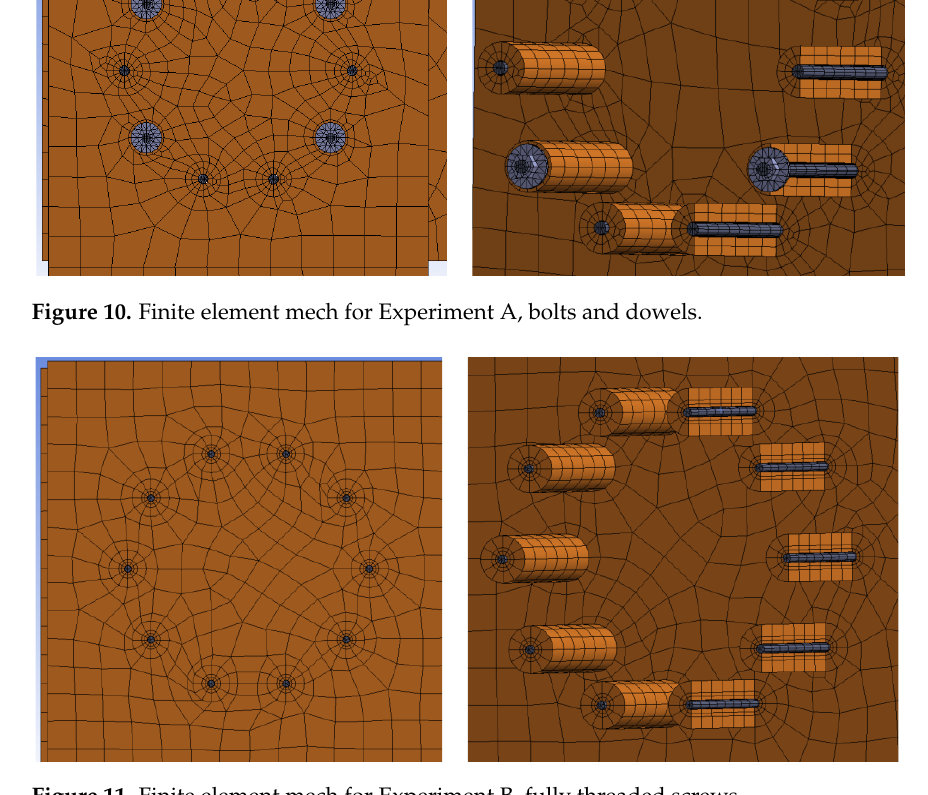
Figure 13. Experiment A: Load – deformation curves of destructive quasi-static cyclic testing for individual specimens made from a combination of bolts and dowels. 3.1.2. Experiment B, Fully Threaded Screws Figure 14 shows broken specimens after the quasi-static destructive experimental testing. Even when testing specimens with fully threaded screws, each specimen was bro- ken in the rung when the tensile stress perpendicular to the grain was exceeded. The fail- ure also occurred in timber outside the glued joint between individual lamellas.